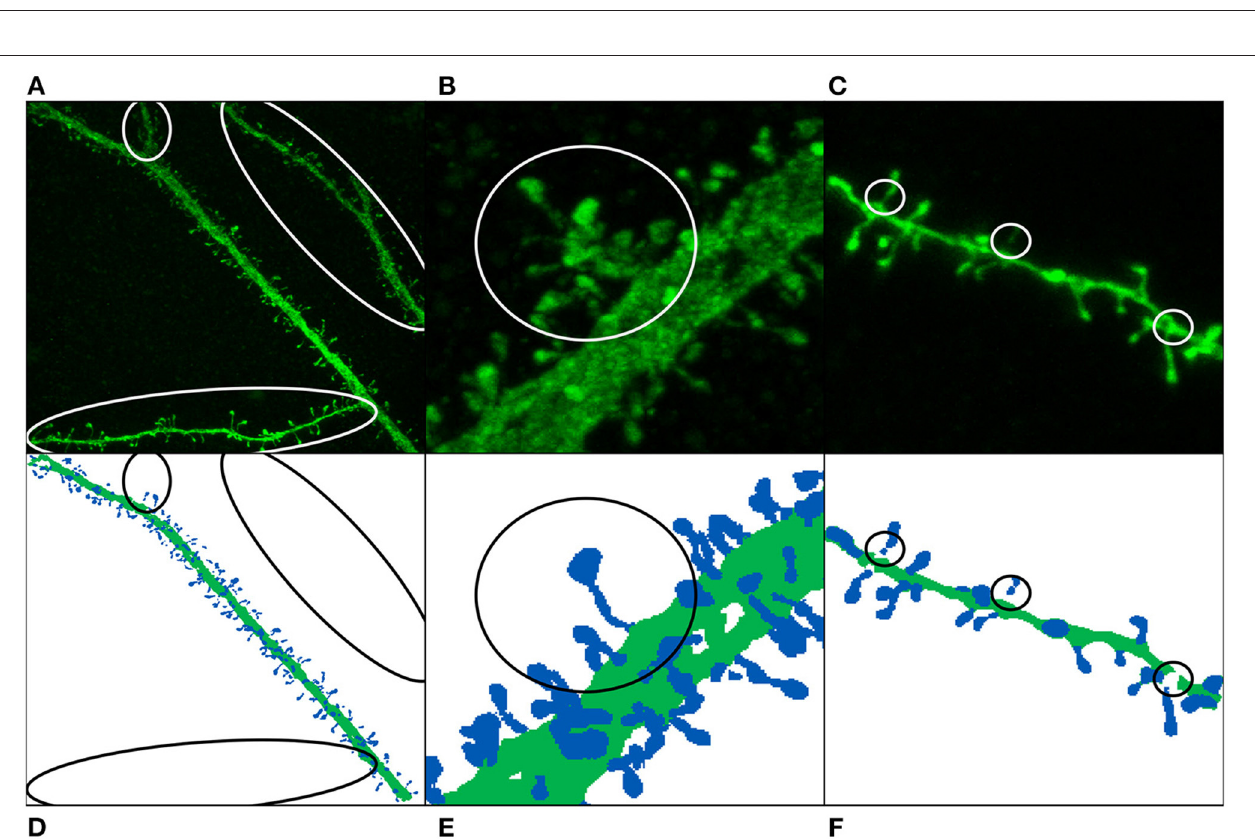
FIGURE 3 | Imaris 3D segmentation and the two steps of the voxelization process: (A) Shows an example of the reconstructed 3D meshes of a dendritic shaft (dark green) and spines (dark blue). The processed spine is highlighted. (B) Illustrates the first step of volumetrization. The voxels of the image are projected into surface coordinate space as 3D boxes. If the projected box of a voxel contains or collides with a surface polygon, the voxel is marked. It should be noted that the voxel projected boxes and surface polygons are 3D structures. Therefore, the surface can collide with more than one voxel in the same stack plane. (C) Shows the second step, where the inner voxels are also marked. All spine stack planes are shown.